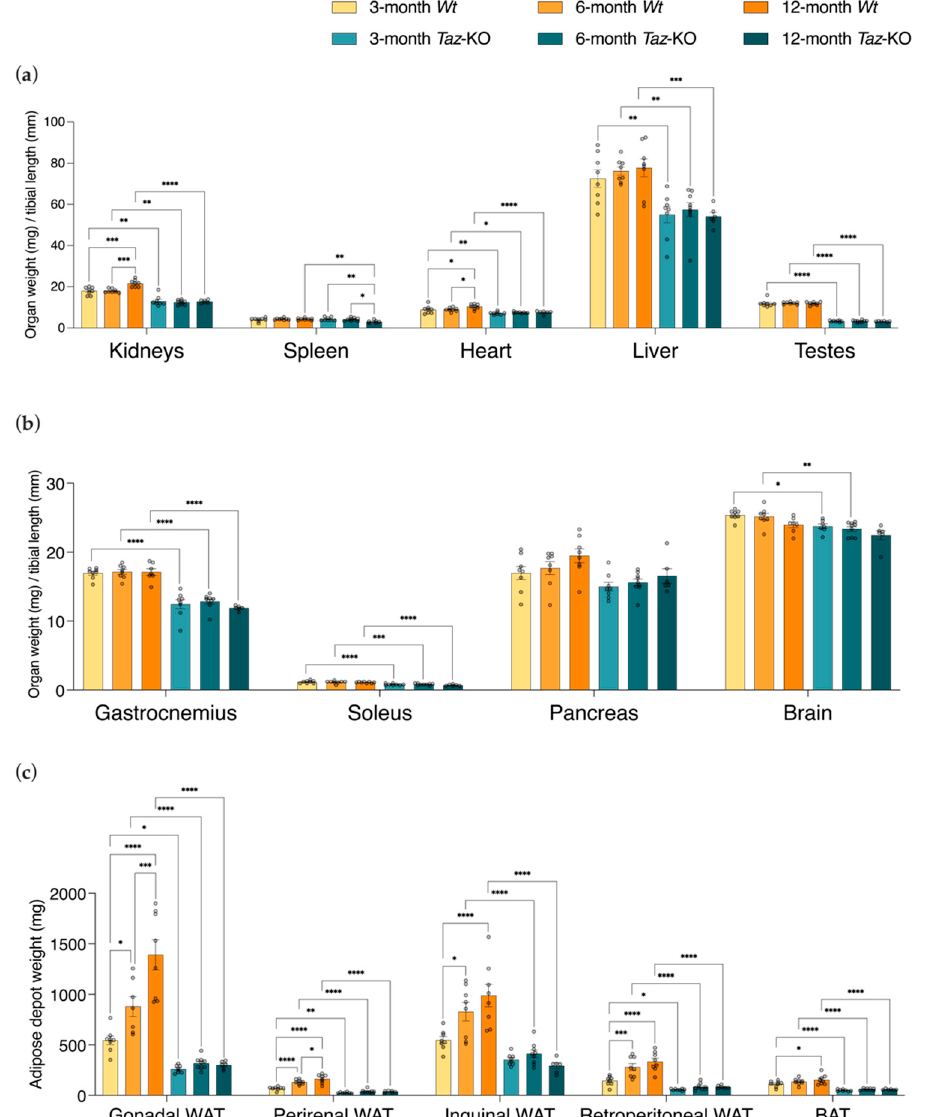
Figure 3. Smaller tissue weights underlie the lower body weights of Taz -KO mice. Taz -KO mice and Wt littermates were necropsied at 3, 6, and 12 months of age. Tibia-normalized weights of kidneys, spleen, heart, liver, and testes ( a ), gastrocnemius, soleus, pancreas, and brain ( b ) are shown. Absolute weights of gonadal, perirenal, inguinal, and retroperitoneal white adipose tissue (WAT) and brown adipose tissue (BAT) ( c ). Data are means ± SEM ( n = 6–8). Statistical analysis was performed using two-way ANOVA followed by Bonferroni’s multiple comparisons tests. * p < 0.05, ** p < 0.01, *** p < 0.001, **** p < 0.0001.